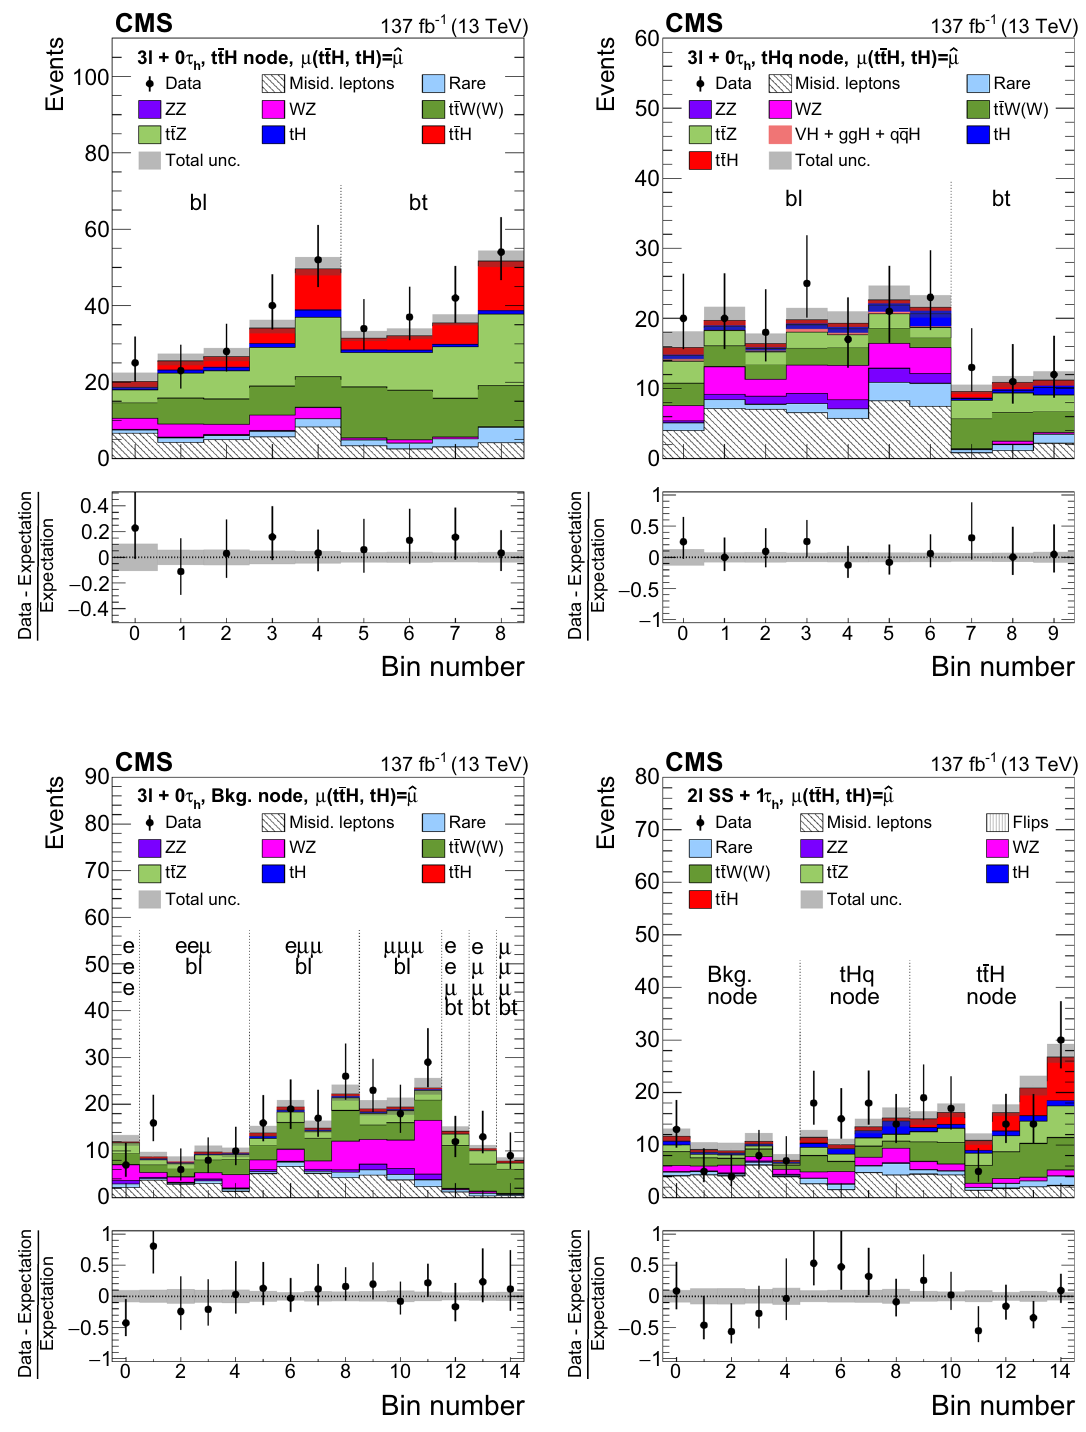
Fig. 9 Distributions of the activation value of the ANN output node with the highest activation value for events selected in the 3 (cid:4) + 0 τ h channel and classified as ttH signal (upper left), tH signal (upper right), and background (lower left), and for events selected in the 2 (cid:4) SS + 1 τ h channel (lower right). In case of the 2 (cid:4) SS + 1 τ h channel, the activation valueoftheANNoutputnodesforttHsignal,tHsignal,andbackground are shown together in a single histogram, concatenating histogram